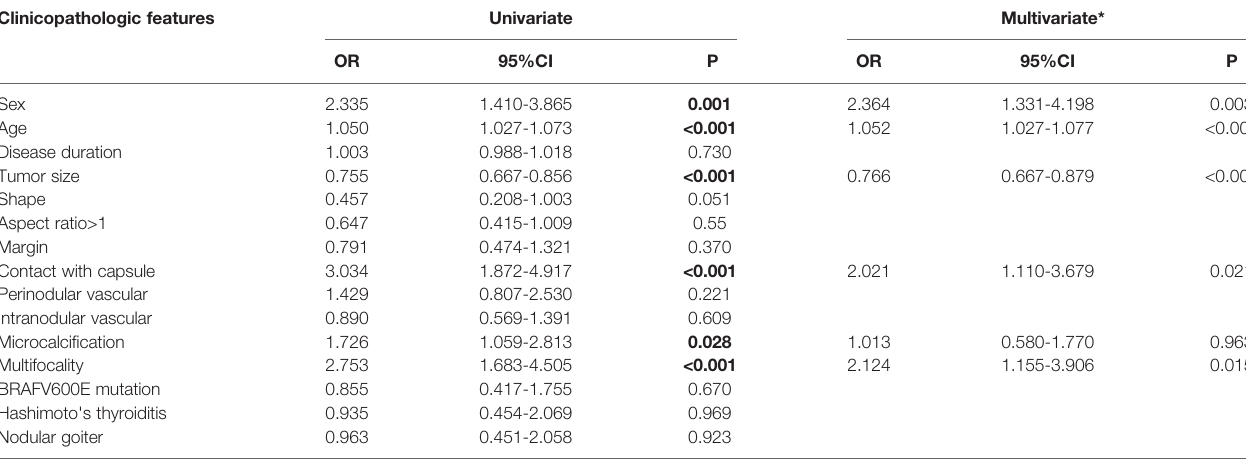
TABLE 3 | Univariate and multivariate analyses to compare the high-risk factors of CLNM in PTC (cT1aN0). Clinicopathologic features